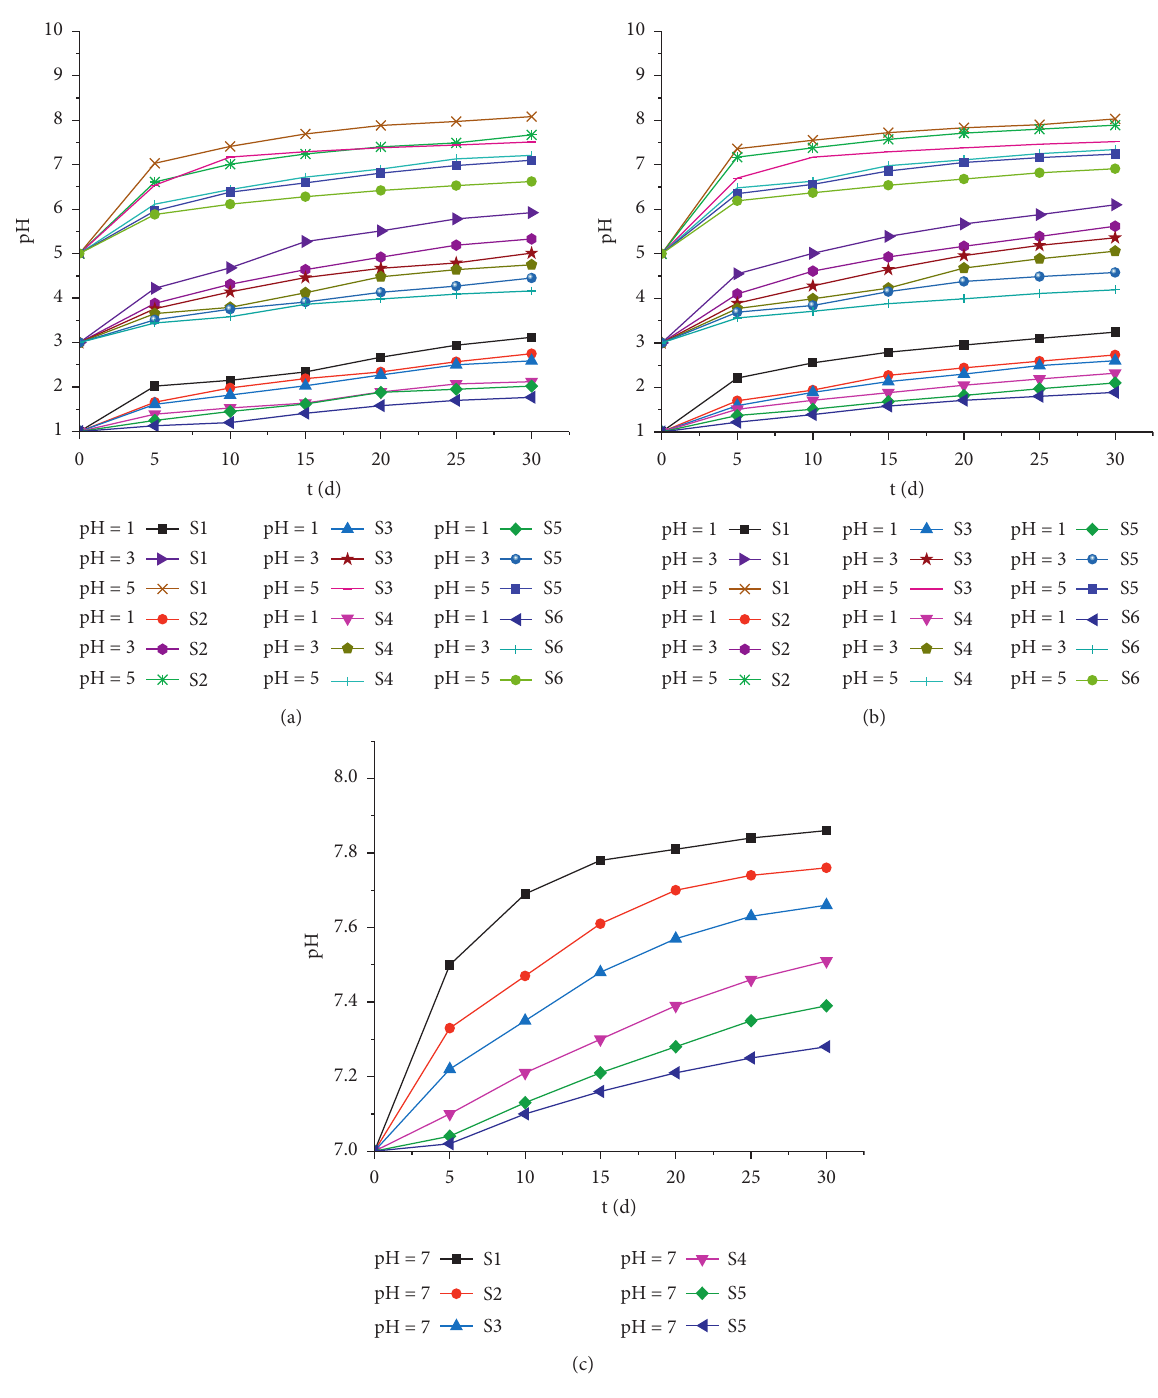
Figure 6: The change law of pH with time in different chemical solutions: (a) H